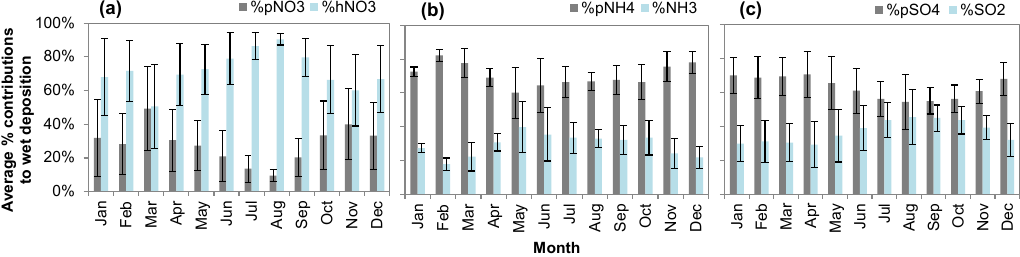
Figure 10. Monthly variation in the contributions of gas- and particulate-phase species to nitrate (a) , ammonium (b) , and sulfate (c) wet deposition. Error bars represent the standard deviation of the percent contributions by gas- and particulate-phase species between sites.